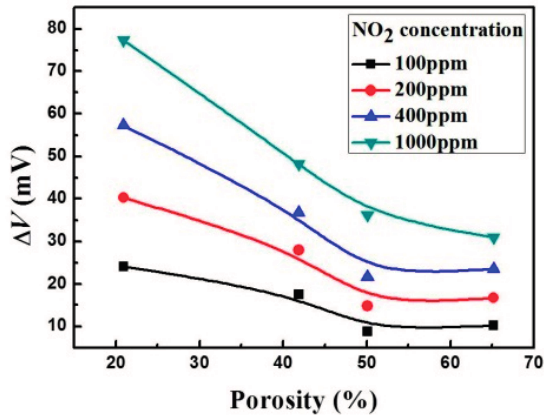
Figure 9. Dependence of potential difference on porosity of thick LSM95